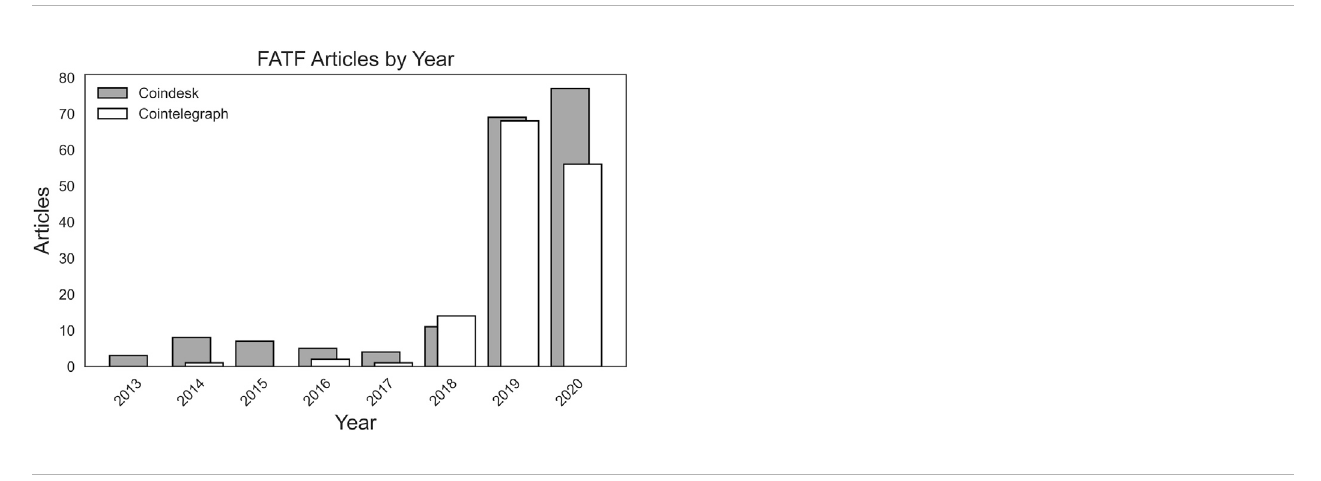
TABLE 1 | Mentions of the FATF in leading industry news